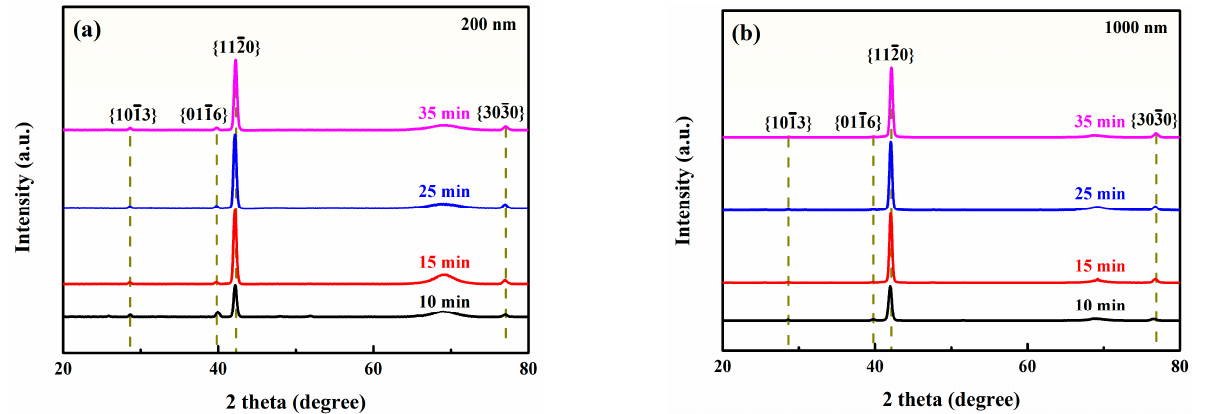
Figure 5. XRD patterns of 200 nm ( a ) and 1000 nm ( b ) Sb 2 Te thin films annealed at different times: 10 min; 15 min; 25 min; 35 min.